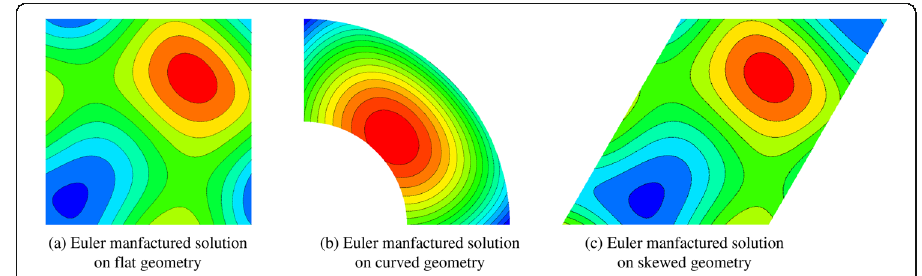
Fig. 11 Density contour of Euler manufactured solutions on different geometries. a Euler manufactured solution on flat geometry. b Euler manufactured solution on curved geometry. c Euler manufactured solution on skewed geometry